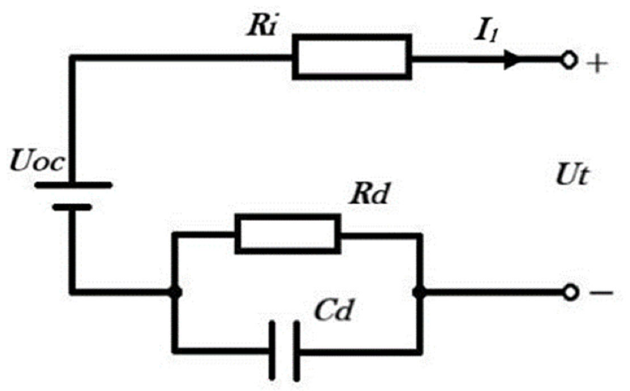
Figure 5. The first ‐ order RC equivalent circuit model. Figure 5. The first-order RC equivalent circuit